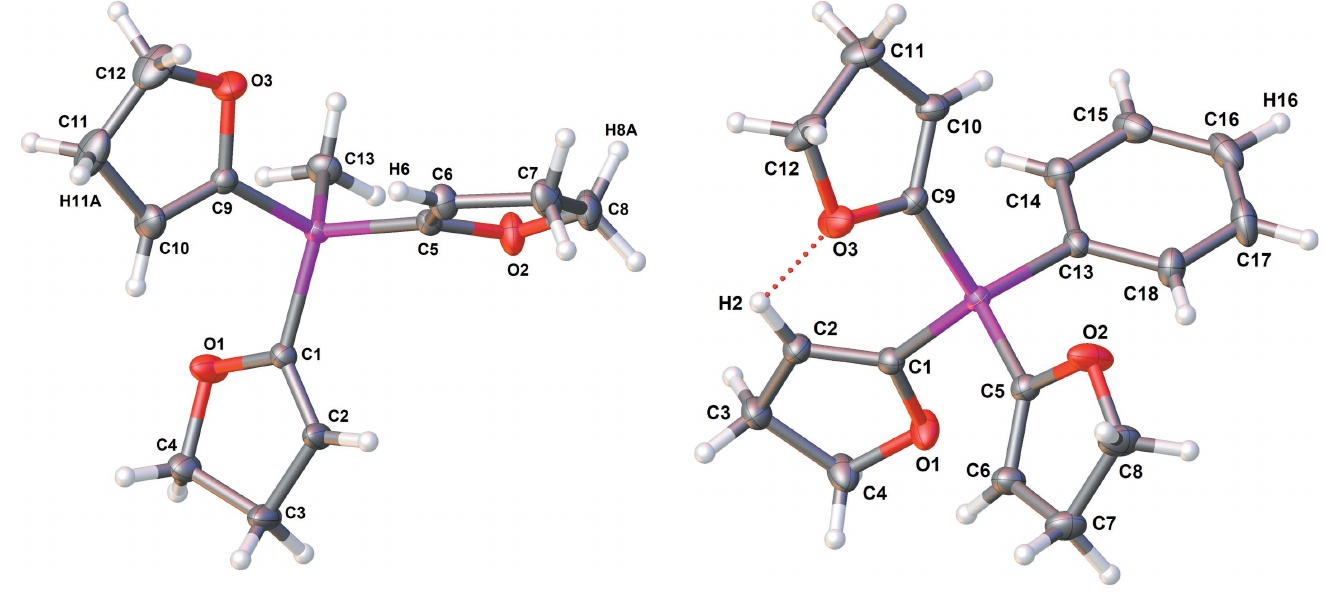
Figure 2 The molecular structure of compound 2 with displacement ellipsoids drawn at the 50% probability level.